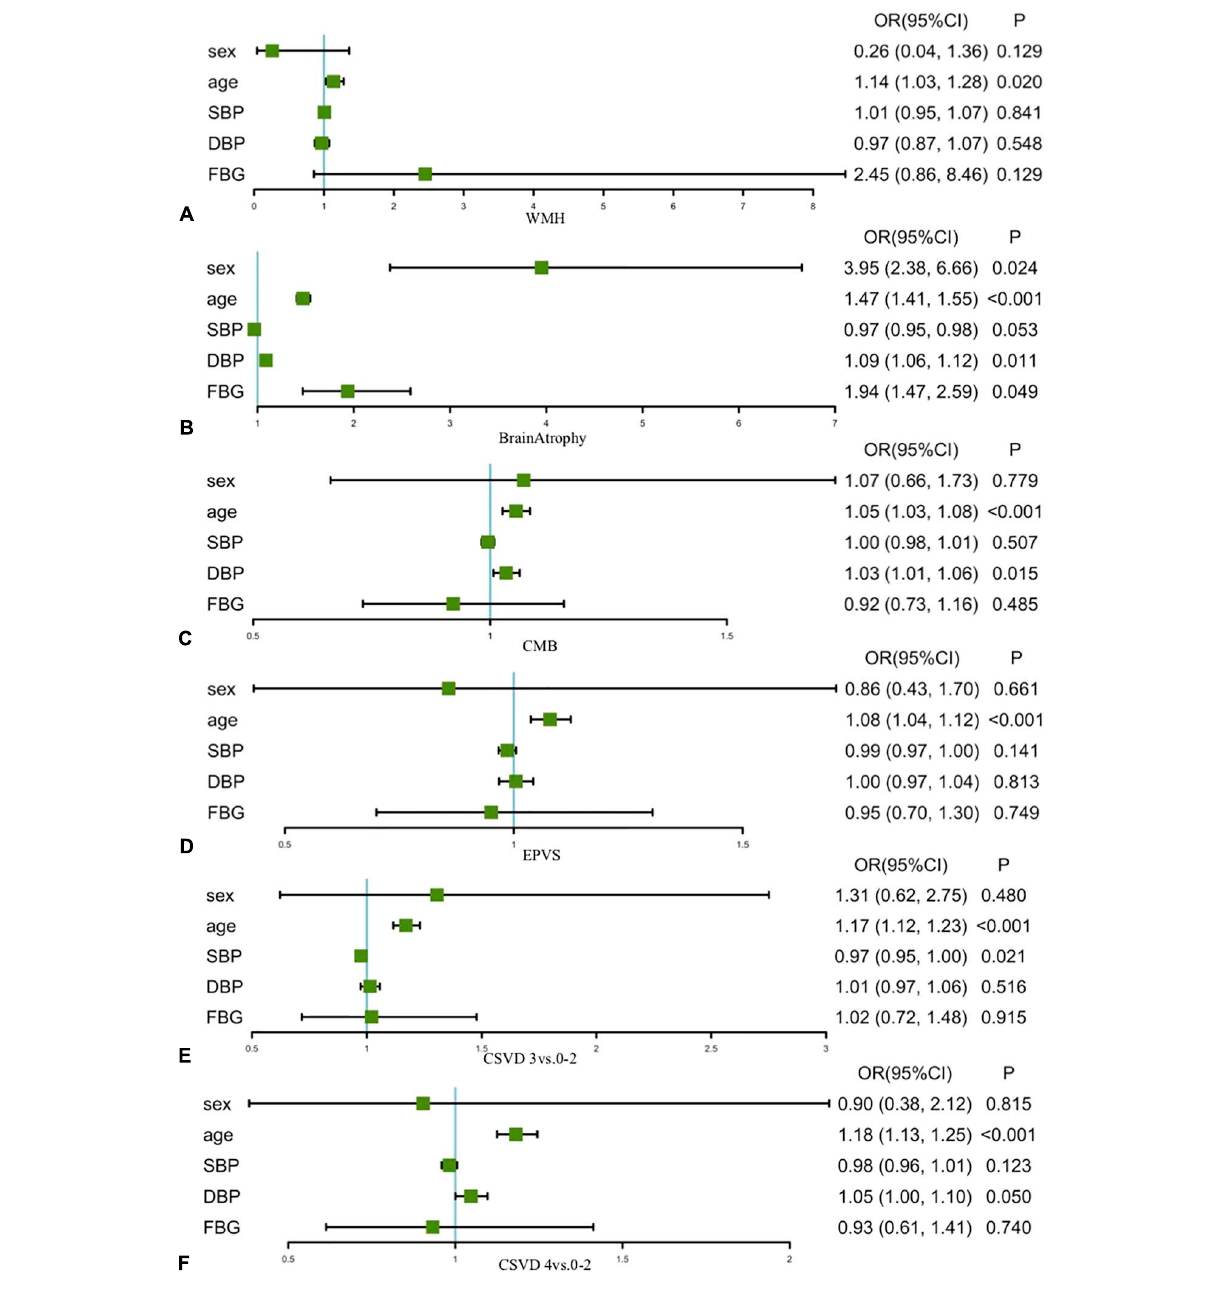
FIGURE 2 | Correlations between cardiovascular risk factors and incidental findings Associations of clinical characteristics with the incidental findings among the participants of the Shanghai Changfeng Study. Age was found to be correlated with (A) WMH, (B) brain atrophy, (C) CMBs, and (D) EPVS and was associated with increasing severity of CSVD markers ( E , CSVD 3 vs. 0–2; F , CSVD 4 vs. 0–2). DBP correlated with brain atrophy and CMBs. FBG was associated with brain atrophy, and males were more likely to develop brain atrophy. OR, odds ratio (95% confidence interval). WMH, white matter hyperintensities; CMBs, cerebral microbleeds; EPVS, enlarged perivascular space; CSVD, cerebral small vessel disease; SBP, systolic blood pressure; DBP, diastolic blood pressure; FBG, fasting blood glucose; PBG, postprandial blood glucose; BMI, body mass